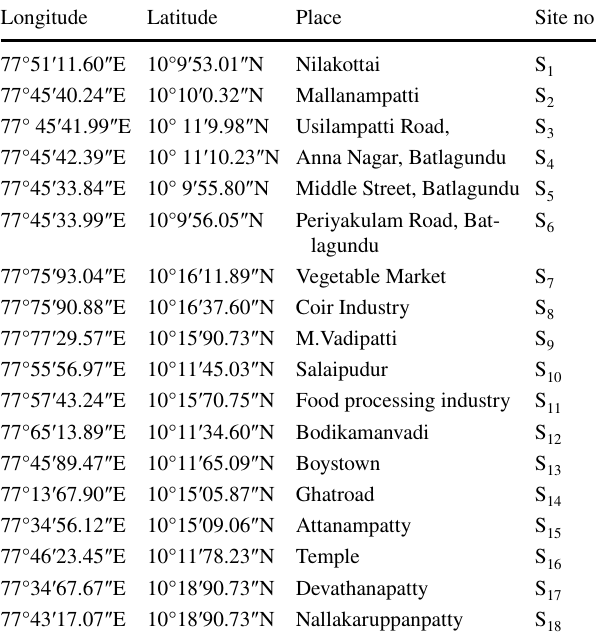
Table 1 Description of sampling sites of Batlagundu block in Din- digul